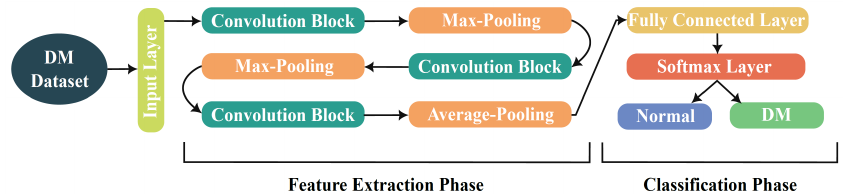
Figure 3. The architecture of the proposed